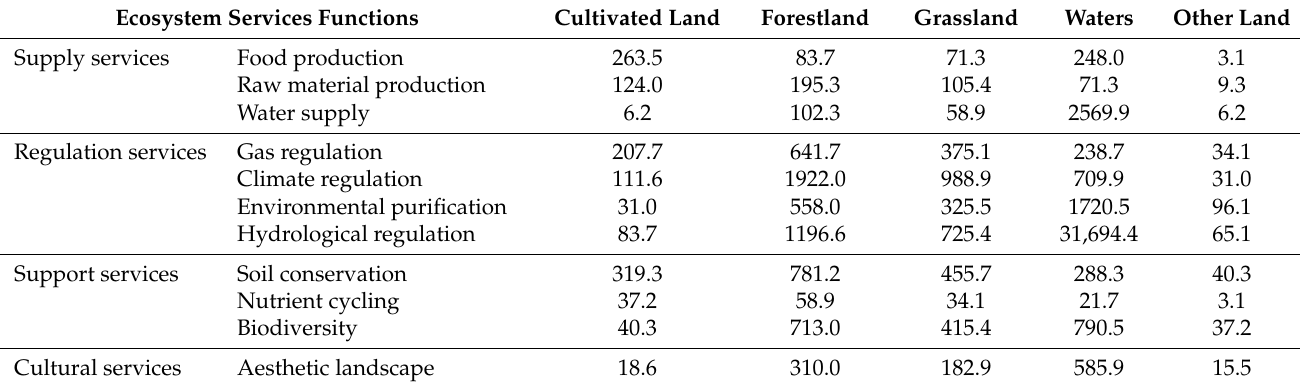
Table 1. Value coefficients of ESV each unit area (yuan/hm 2 ·